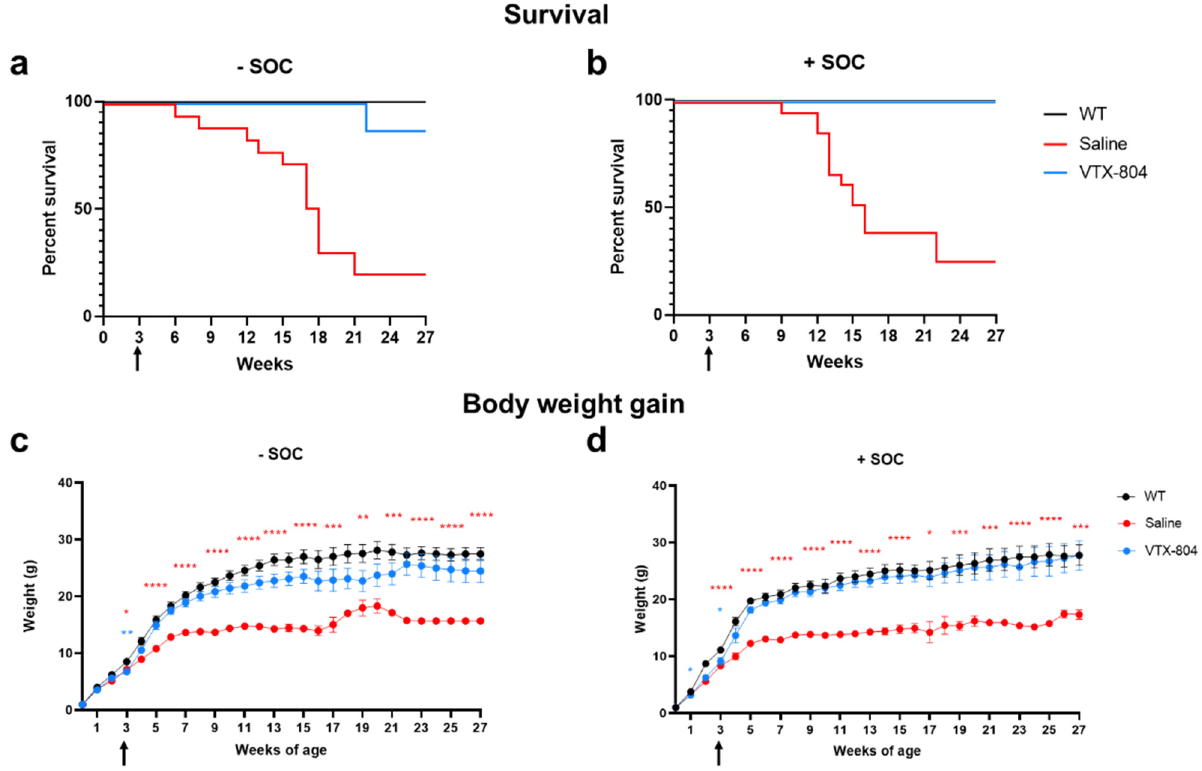
Figure 1. Survival rate and body weight gain of wild-type and Ass1 fold mice. Ass1 fold mice treated with saline or VTX-804 vector with or without pretreatment at three weeks of age and wild-type mice were analyzed for survival ( a , b ) and weekly for weight gain ( c , d ) for 27 weeks. All three groups were also treated daily with nitrogen scavengers and arginine from birth to weaning (SOC) ( b , d ). At three weeks of age, Ass1 fold mice were injected with the VTX-804 vector (n = 16), at a dose of 1 × 10 14 vg/kg (indicated with an arrow). Controls included saline treated Ass1 fold mice (n = 18) and healthy WT mice (n = 16). * vs. WT mice. Data are mean ± SEM. Two-way ANOVA. * p < 0.05, ** p < 0.01, *** p < 0.001, **** p < 0.0001.